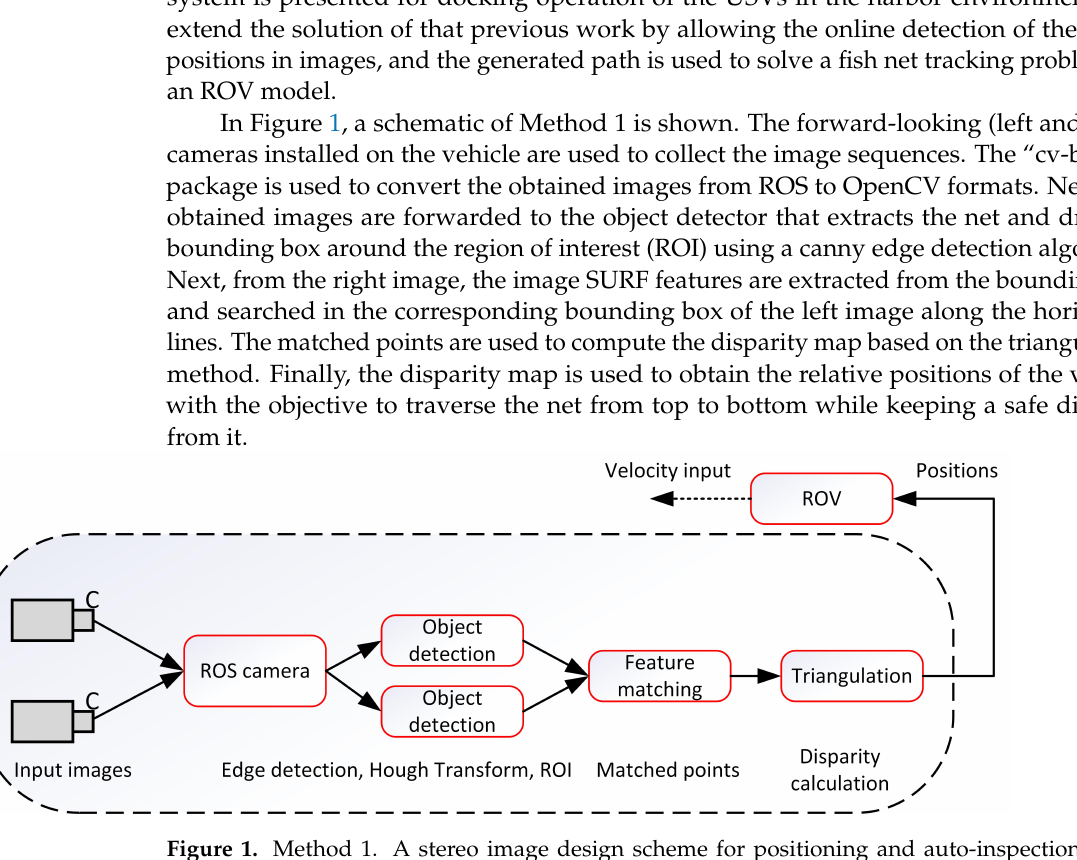
Figure 1. Method 1. A stereo image design scheme for positioning and auto-inspection of the underwater fish cage net adopted from [27].